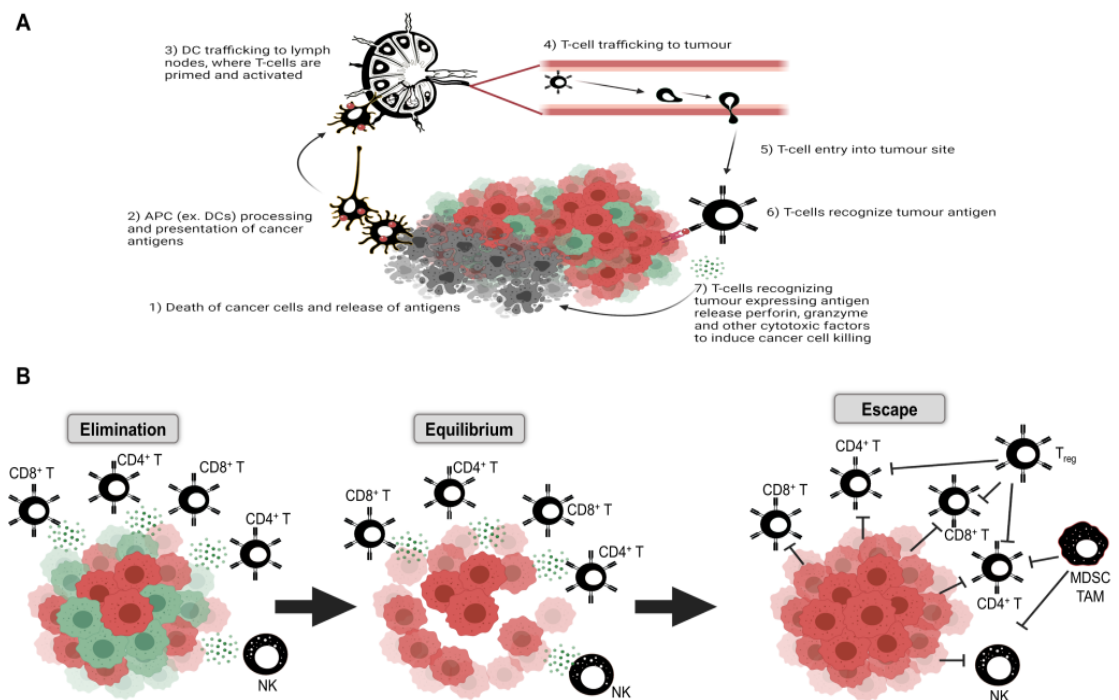
Figure 2. Cancer immunity cycle and immunoediting. ( A ) Cancer immunity cycle, as outlined by Chen and Mellman [161]. ( B ) Steps in the cancer immunoediting concept, with immune cell elimination of cancer cells; cancer-immune equilibrium; and escape through a multitude of immunosuppressive mechanisms (image created with BioRender.com, accessed on 21 September